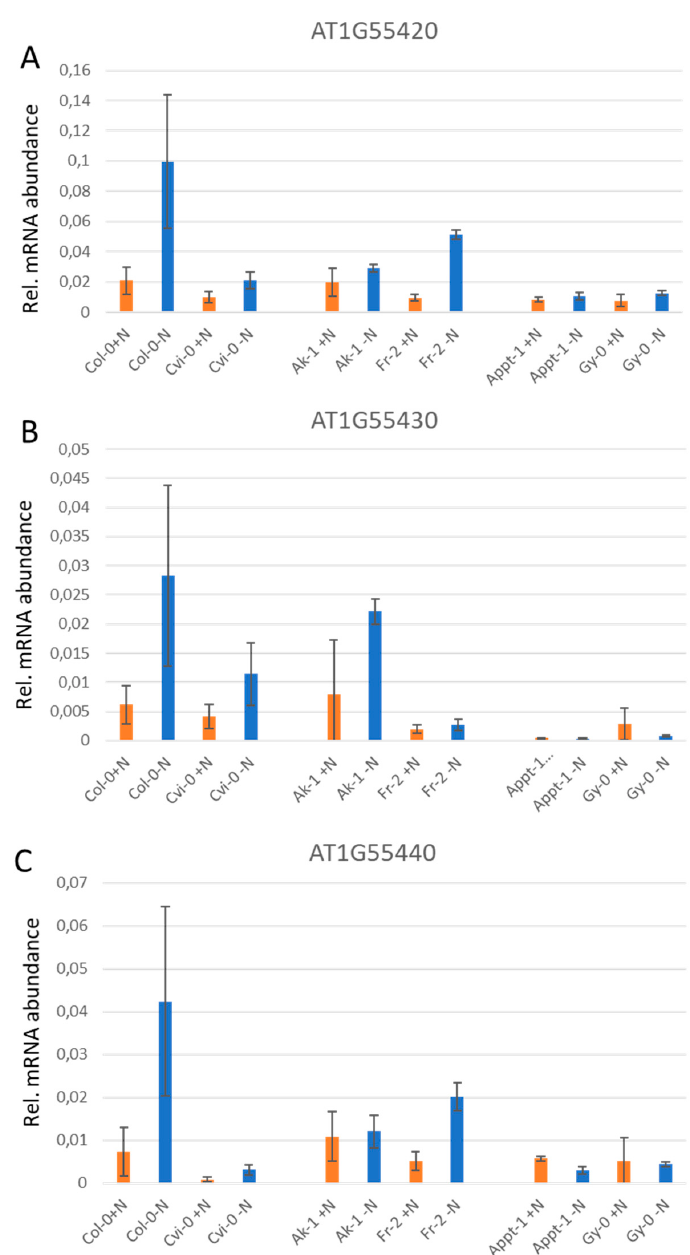
Figure 7. Relative mRNA abundance of identified genes in the QTL region under +N and -N conditions. Analysed were selected accessions with differences in the methylation pattern. Left part: detected methylation signatures, right part: absent methylation signature. Bars indicate the means of 6 biological replicates (3 technical replicates) with standard deviations. ( A ) mRNA abundance of AT1G55420 ( EDA11 ), determined by real-time qPCR, relative to ACTIN11 mRNA in root tissue. ( B ) mRNA abundance of AT1G55430 , determined by real-time qPCR, relative to ACTIN11 mRNA in root tissue. ( C ) mRNA abundance of AT1G55440 , determined by real-time qPCR, relative to ACTIN11 mRNA in root tissue.